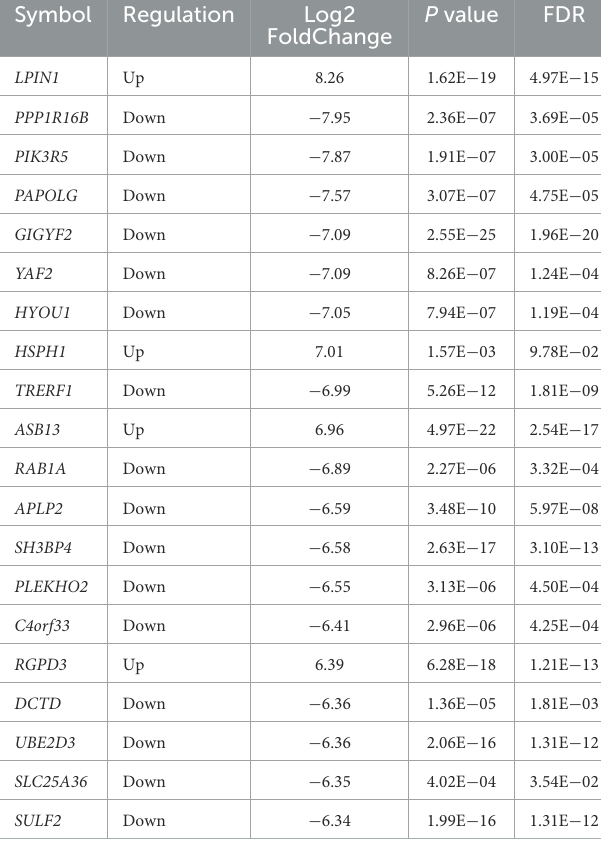
TABLE 2 Top 20 differential expression mRNAs between first-episode, drug-naive adolescents with MDD and HCs. Symbol